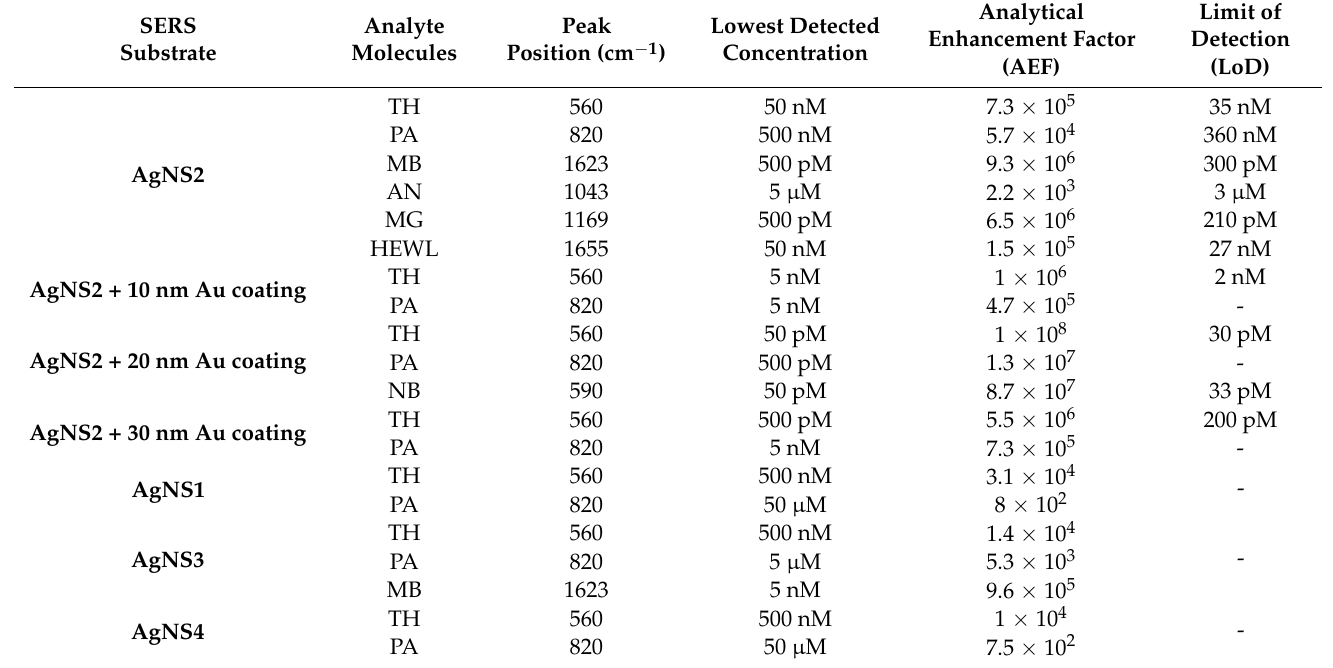
Table 1. Summary of the estimated AEFs for various analyte molecules involving all the substrates investigated in the present study. Here, AgNS1, AgNS2, AgNS3,